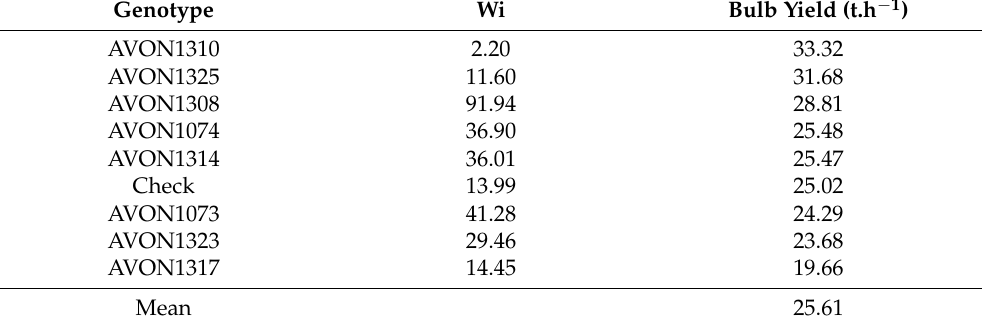
Table 4. Wricke’s ecovalence stability of coefficients Wi.